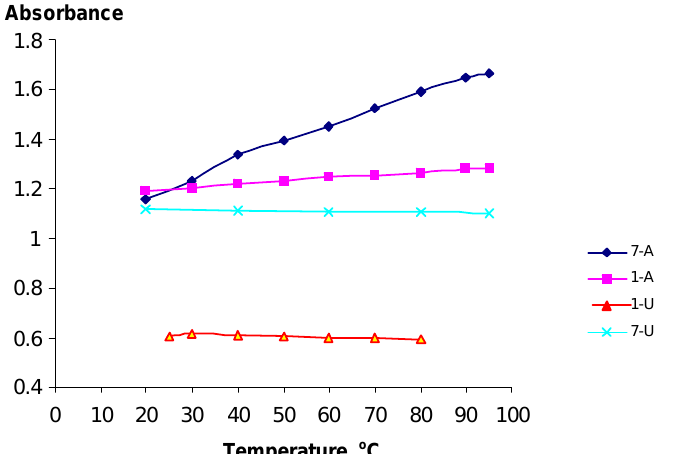
, 1-A , 7-U and 7-A . 8 9 8 6